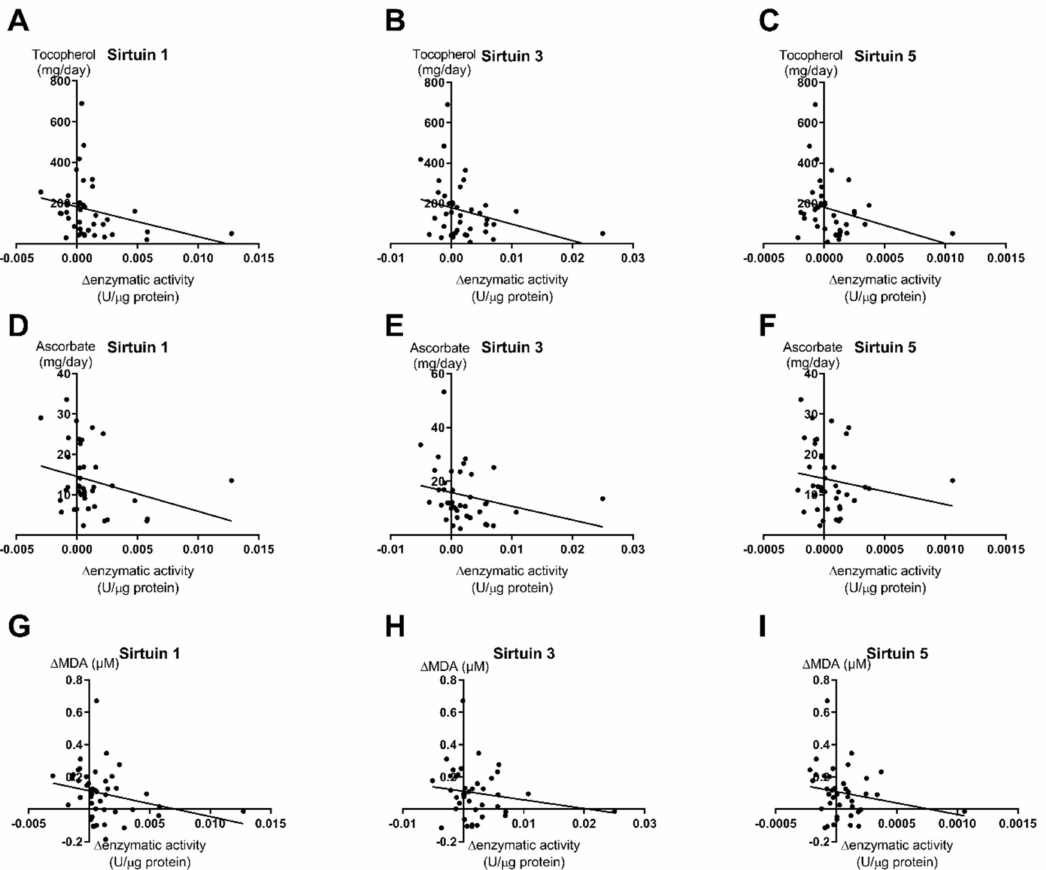
Figure 5. Correlations of calculated tocopherol and ascorbate intake with SIRT1, SIRT3, and SIRT5 capacity levels. The figure shows the correlations of changes in enzyme capacities (post-pre exercise) with either tocopherol ( A – C ), ascorbate ( D – F ) or MDA ( G – I ) for all analyzed sirtuins. For correlation analyses, all study groups were pooled ( n = 71). Correlations for tocopherol and ascorbate with SIRT1 were statistically significant; statistical analysis with Spearman’s correlation test.